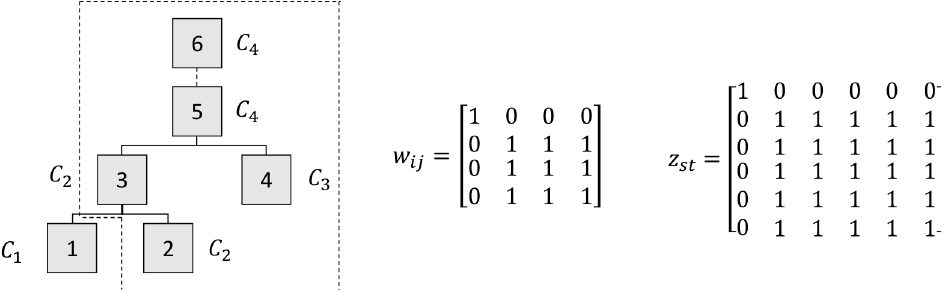
s with n = 4, m = and y st i